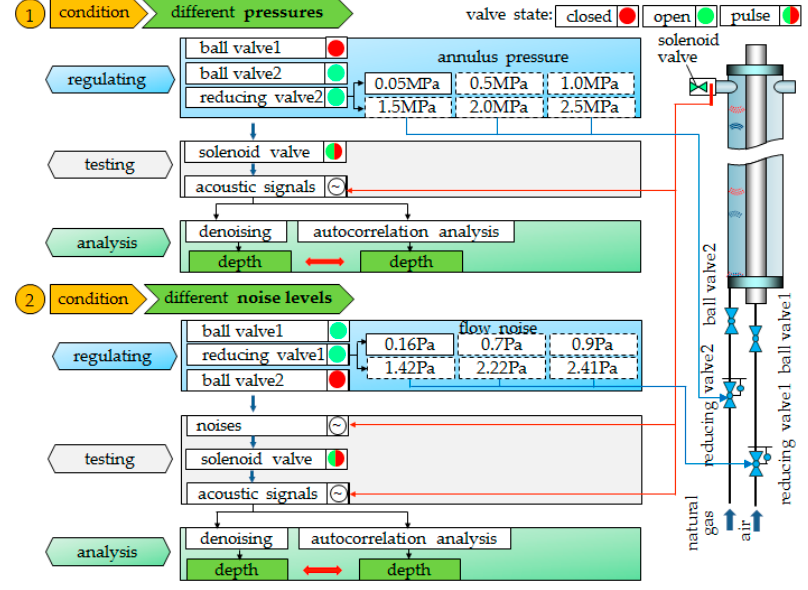
Figure 9. Experimental process of liquid level detection under different operating conditions.